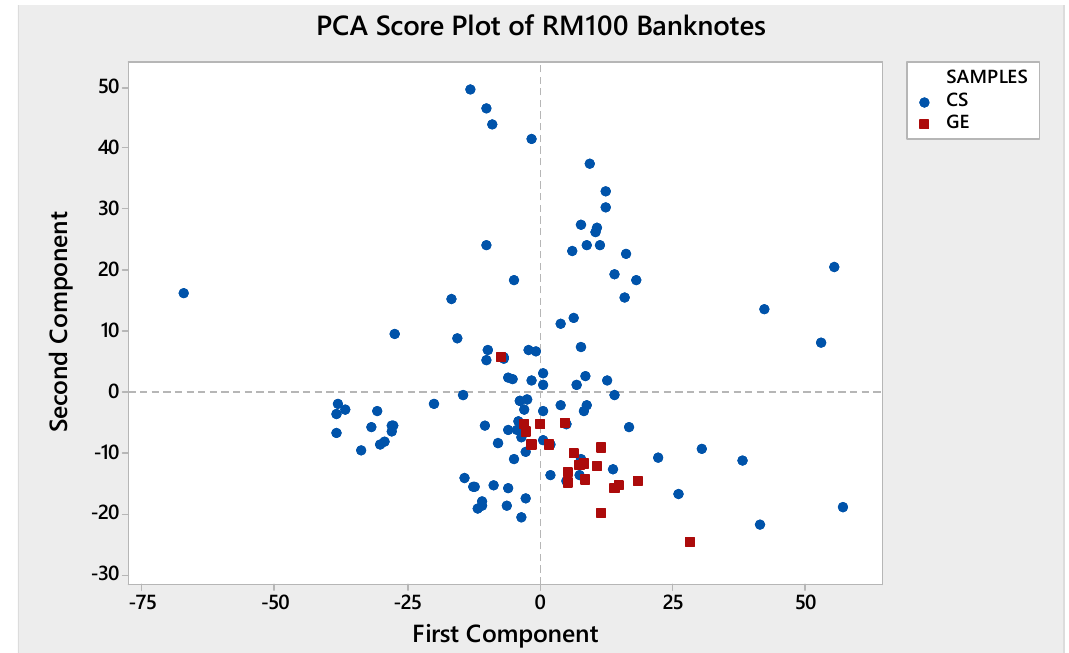
Figure 7. The PCA score plot of genuine (GE) and counterfeit (CS) RM100 banknotes samples.